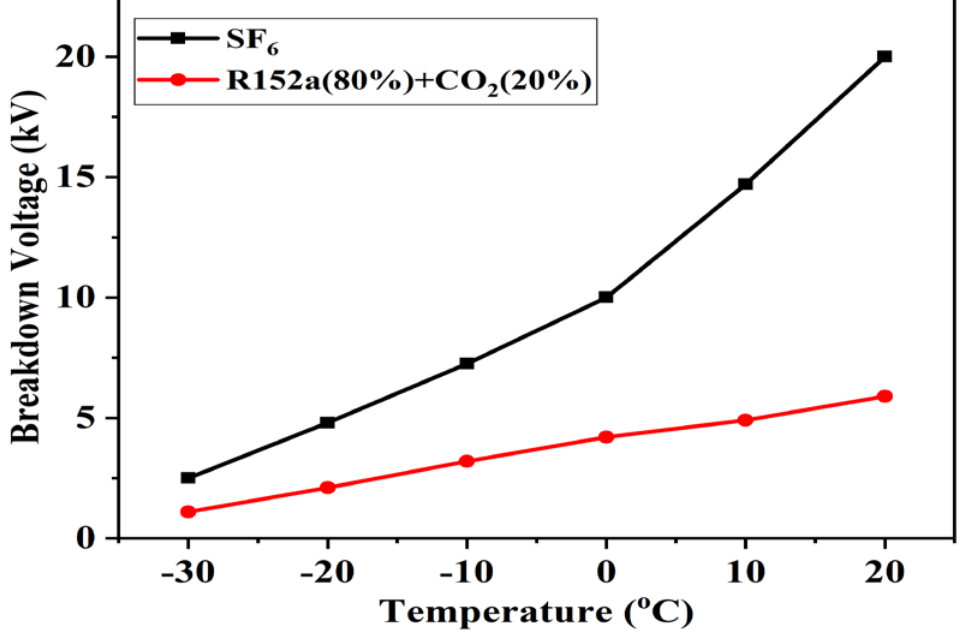
Figure 8. Saturated vapor pressure R152a and SF 6.